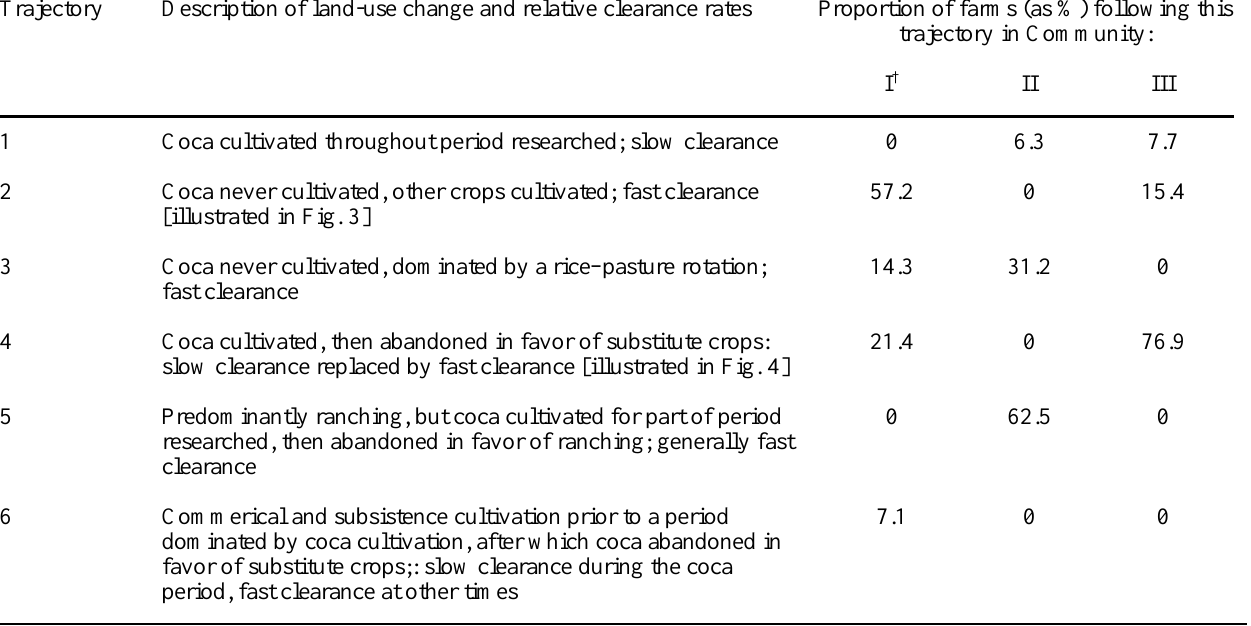
Table 5. Forest clearance